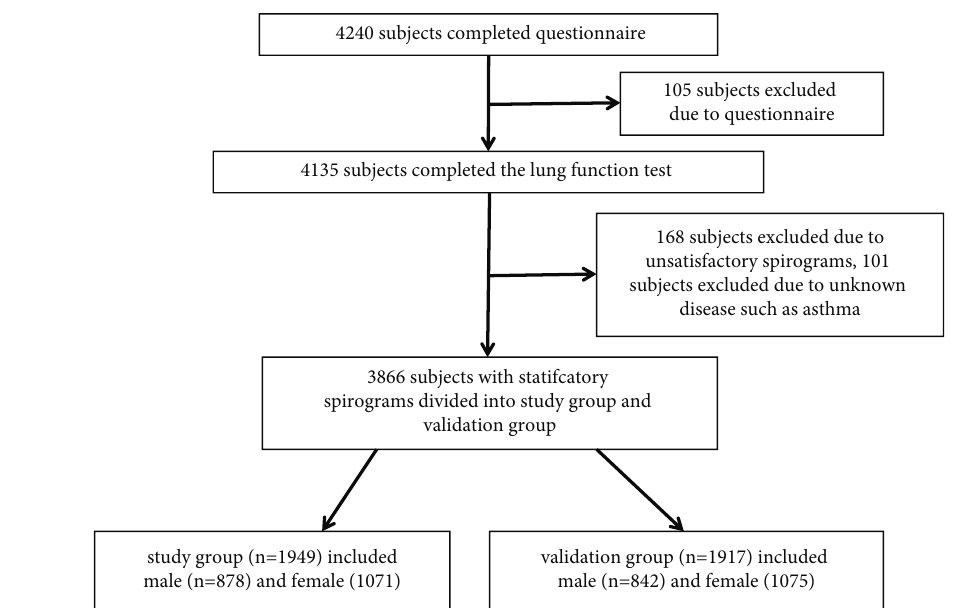
Figure 1: Flowchart of subjects included into the study.